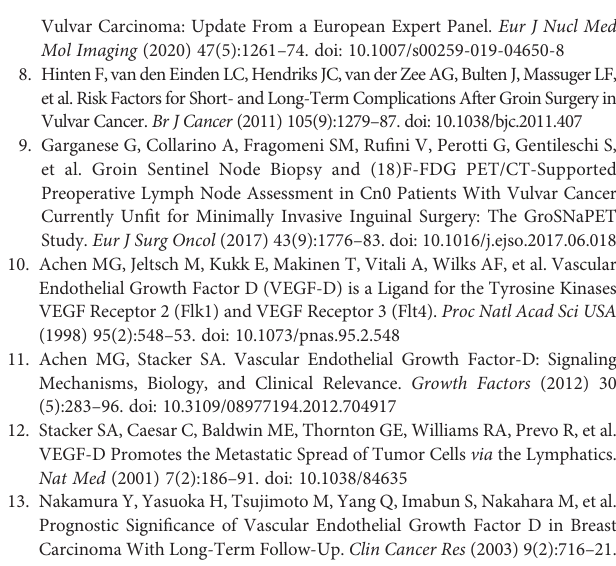
Supplementary Figure 3 | Calibration curve for the penalized extended model applied to the validation cohort